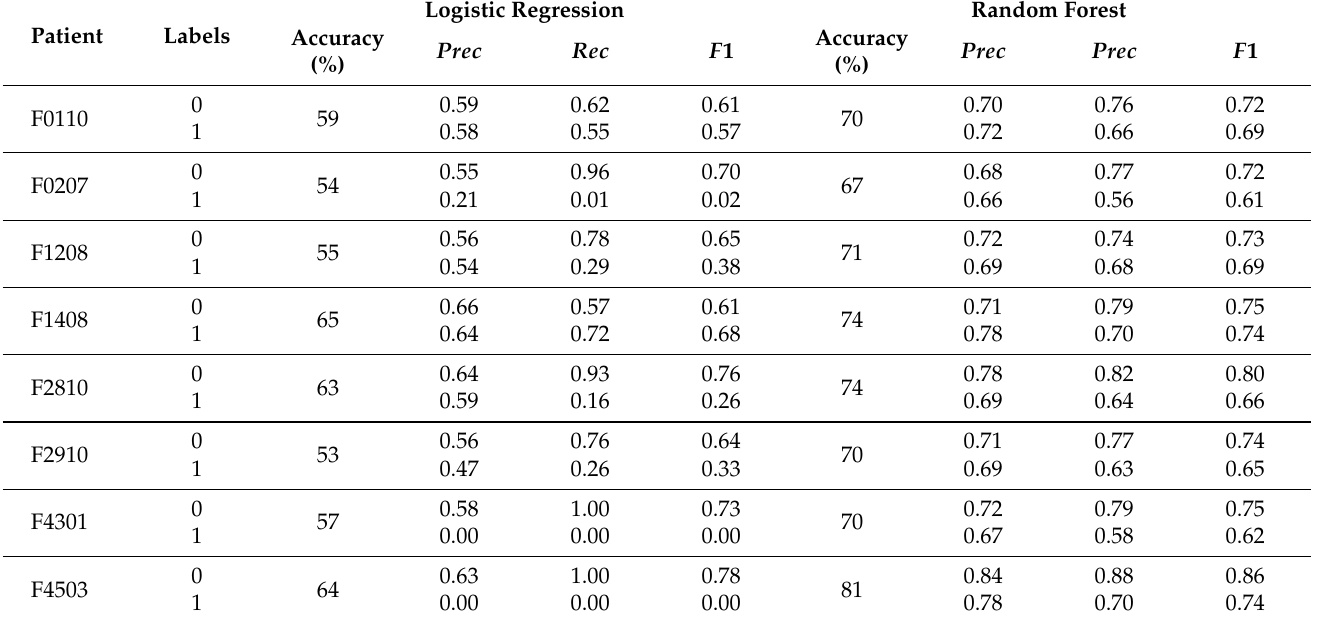
Table 1. Logistic Regression and Random Forest Performance